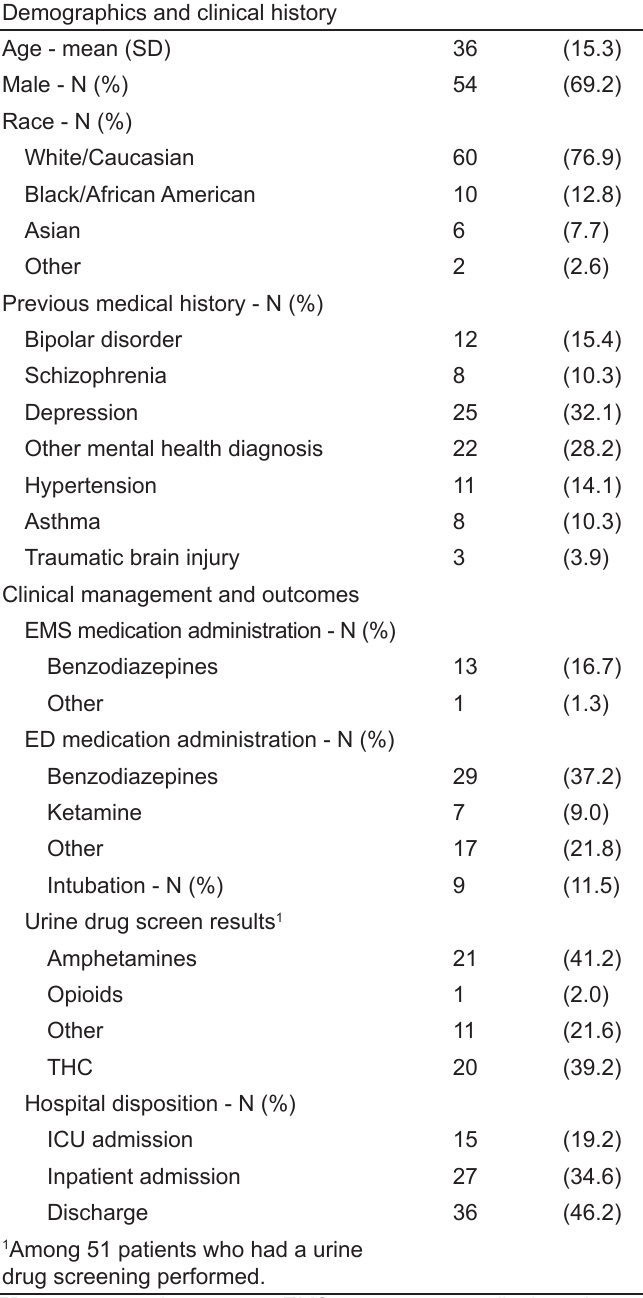
Table 1. Characteristics of patients receiving ketamine in the prehospital